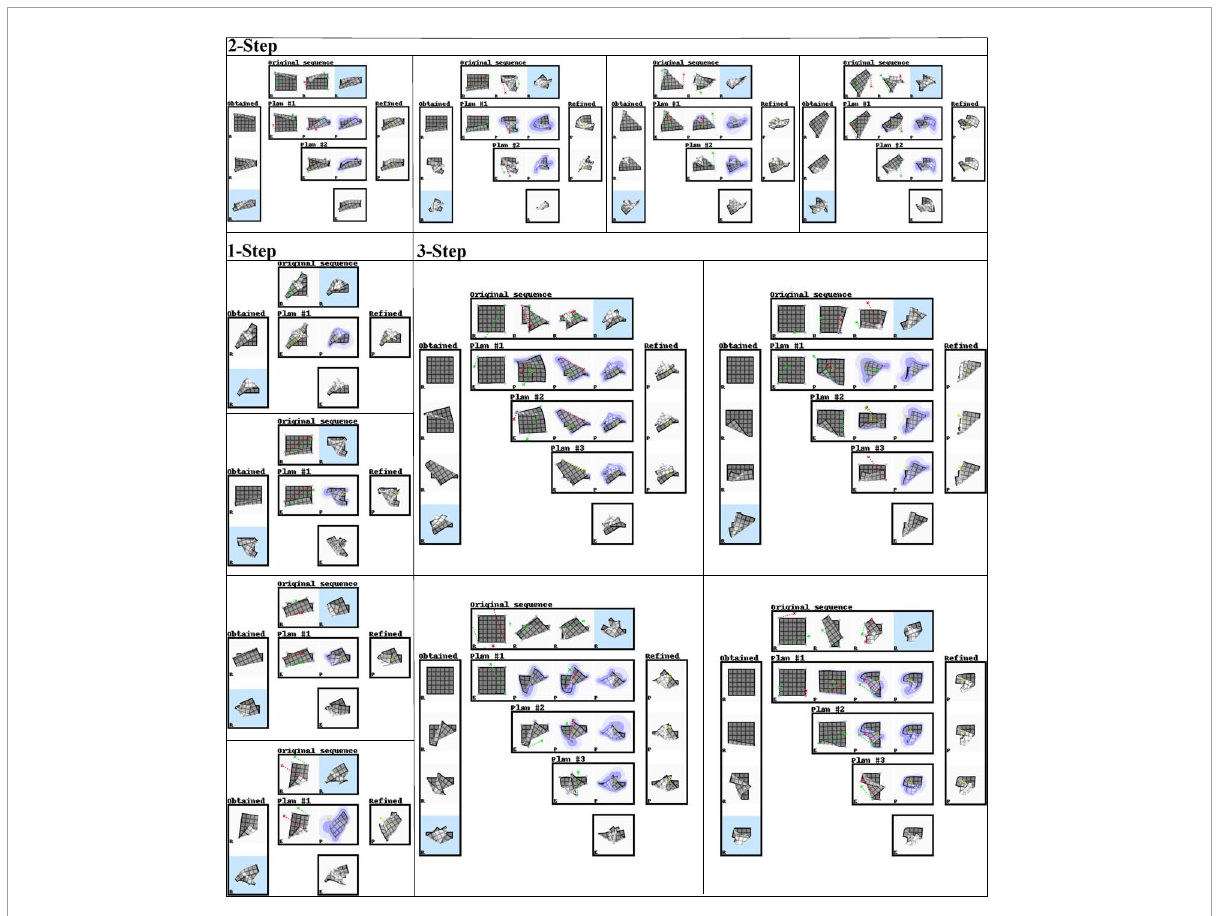
FIGURE9 Representative examples of planning and execution sessions (test set data, dual-net planning). In each panel, the top row shows the original manipulation sequence. The system only sees its estimate of the current state and the final state of the original sequence (i.e., the goal state, marked with light blue background). The left column shows the sequence of cloth shapes obtained over the course of the session. The final outcome is marked with a light blue background. Rows marked “Plan # i ” show the i th plan generated in the session. Each plan starts from an estimate (DMR) of the current shape, generated through the VtM net and refinement with subsequent shapes being predictions (PMRs) generated by the pEM*D net. Under the last plan, we see the system’s estimation of the obtained outcome. The right column shows the result of applying the refinement procedure to the predicted outcome of each plan. These are added for illustration, and not used by the system. They represent a plausible deterministic shape drawn from the probabilistic prediction of each plan’s outcome. All shapes are marked in their bottom left corner to indicate the shape type: R = real, E = estimation, P = prediction. Red and green dotted lines show manipulation trajectories. Lilac circles mark grasp point